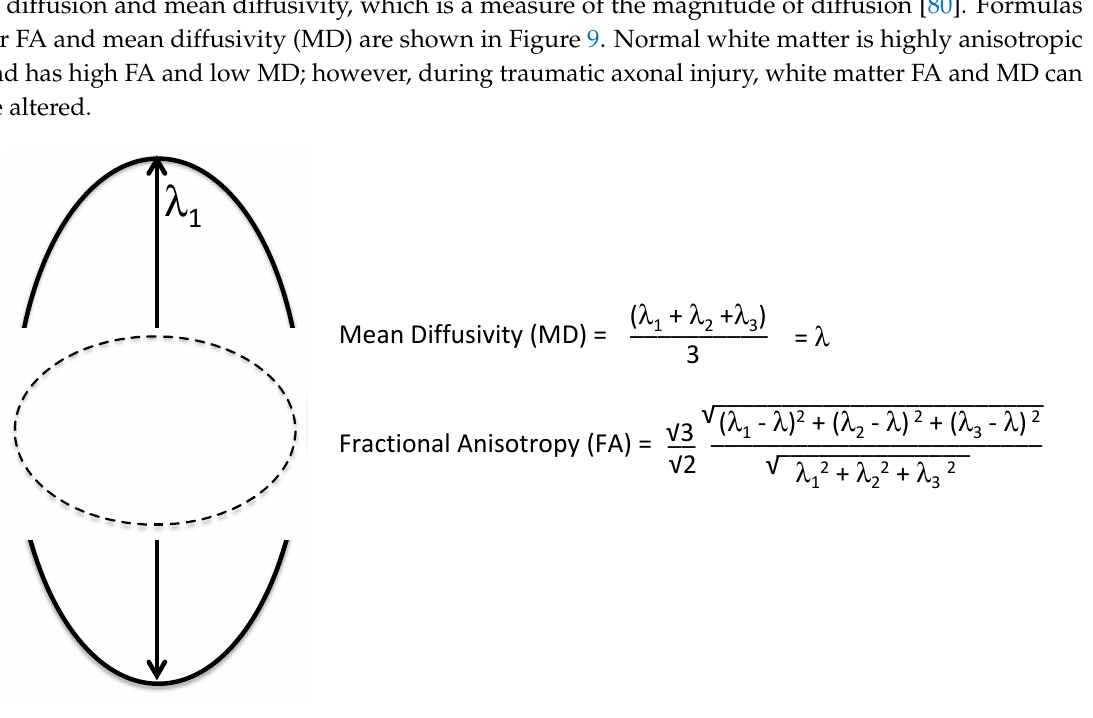
Figure 8. T1-weighted and diffusion tensor imaging (DTI). ( A ) Contrast-enhanced T1-weighted image. Note that the white matter is all the exact same grayscale and the direction of each white matter tract cannot be discerned. ( B ) Grayscale DTI anisotropy map for one diffusion-sensitizing gradient. Note that there are varying grayscales within the white matter, which correspond to the amount of diffusion signal for the particular directional diffusion-sensitizing gradient applied during the acquisition. ( C ) Color DTI anisotropy map overlaid onto a T1 post-contrast image. The Color DTI anisotropy is based on the composite of multiple diffusion-sensitizing gradient images. Note that there are multiple colors within the white matter map with red indicating transverse direction, blue indicating superior–inferior direction and green indicating anterior-posterior direction.